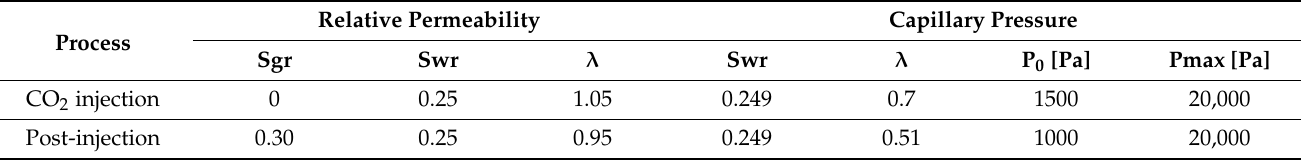
Table 2. Van Genuchten–Mualem model parameters used for simulating sandstone Pc and Kr